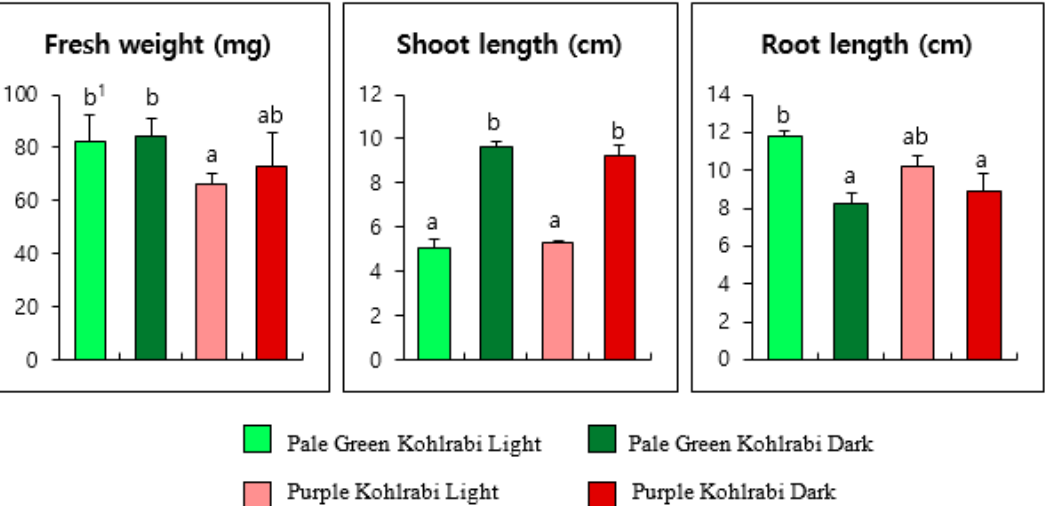
Figure 2. Effect of light and dark treatment on the growth of pale green and purple kohlrabi sprouts. 1 Values followed by different letters within a column indicate a significant difference ( p < 0.05) between areas for that parameter using DMRT ( n ≥ 5, mean ± SD).